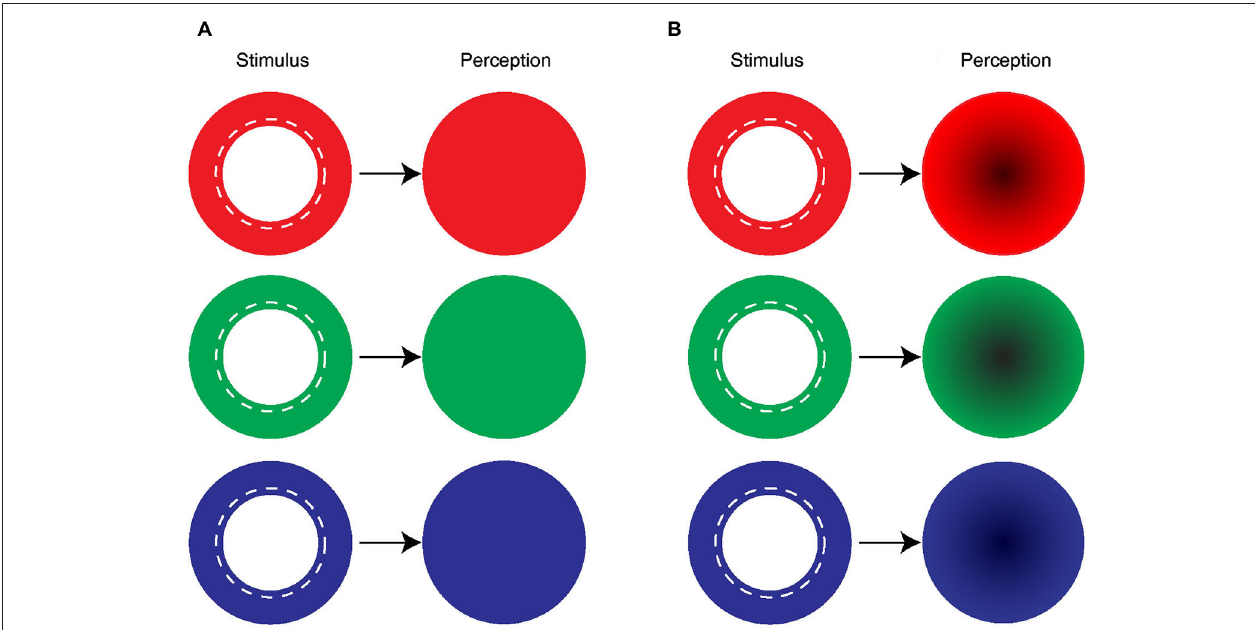
FIGURE 2 | Uniform and symmetrical filling-in by mono-colored ring. (A) The majority of the subjects reported seeing a uniformly colored disk in their blind spot area when the blind spot boundary was covered by a mono-colored ring. (B) Some of the subjects described a uniformly colored disk with a darker center.